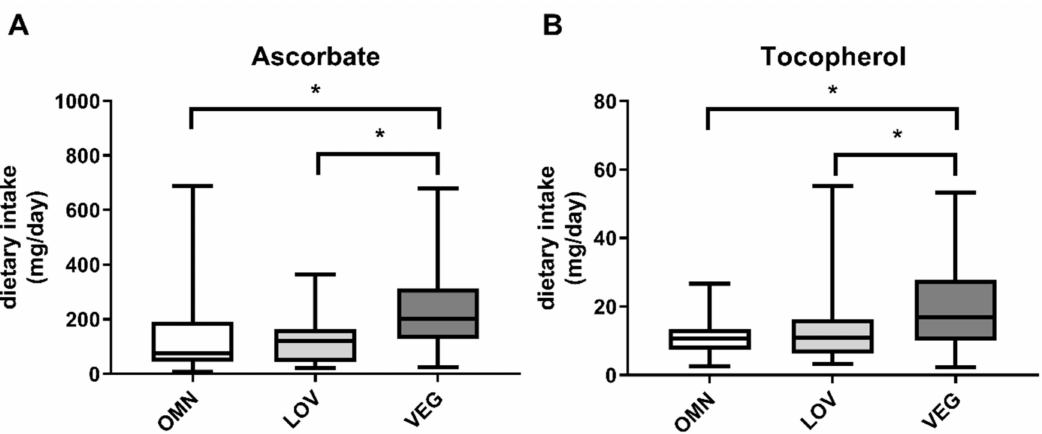
Figure 6. Intake of ascorbate ( A ) and tocopherol ( B ) in the three analyzed study groups of omnivores (OMN), lacto-ovo vegetarians (LOV), and vegans (VEG) during 24 h dietary recall. Data are shown as median ± quartiles and extrema; n = 21–25; statistical analysis with Kruskal–Wallis test and Dunn´s multiple comparison test; * p <